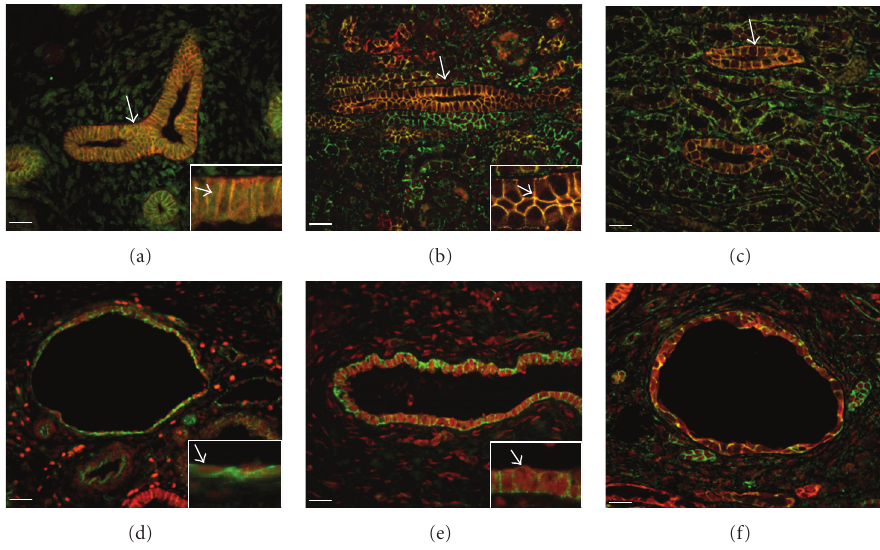
Figure 3: E-cadherin and β -catenin immunoreactivity (IR) . Normal kidneys ((a)–(c)). (a) In the early gestation kidney (10 weeks), E-cadherin- IR (red) and β -catenin-IR (green) are localized in the cytoplasm (arrows). (b) Colocalization of E-cadherin-IR and β -catenin-IR (yellow) to the intercellular junctions is well established by late gestation (27 weeks) (arrows), and (c) persists in the normal postnatal (12 months) kidney (arrow). Obstructed kidneys ((d)–(f)). (d) Disruption of E-cadherin-IR and β -catenin-IR colocalization at the intercellular junctions, with translocation of β -catenin-IR to the cytoplasm (green) and of E-cadherin-IR to the nucleus (red) (arrows in inset) in the (d) mid gestation kidney (18 weeks), (e) late gestation kidney (36 weeks), and (f) postnatally (16 months kidney). Scale bar = 25 μ